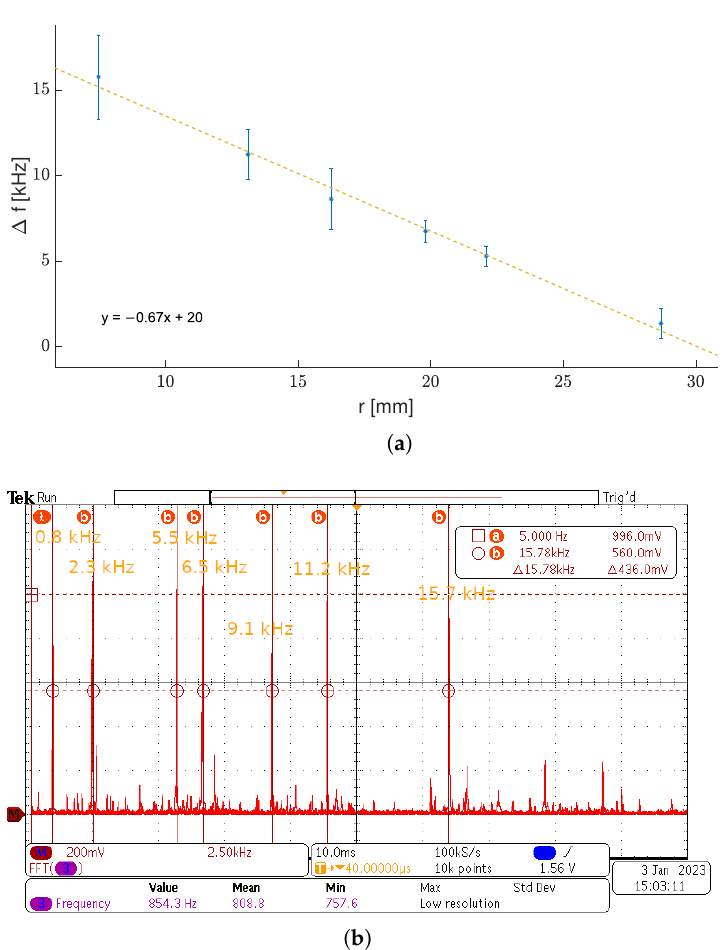
Figure 18. Frequency measurements of a physical sensor structure, output frequency vs. bending radius ( a ) and ( b ) the frequency–domain response of the sensor for variable radius.